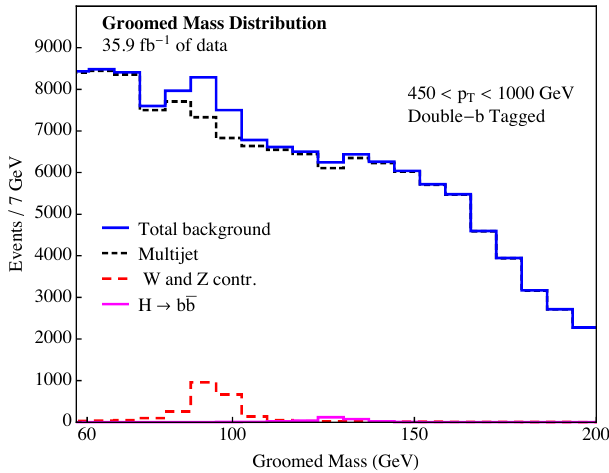
Figure 2 . Groomed mass distribution for signal and background (including leading order vector boson contributions). The small Higgs boson signal is visible near m SD simulation statistical uncertainty is comparable to the data statistical uncertainty. While not ideal, this does not qualitatively change the